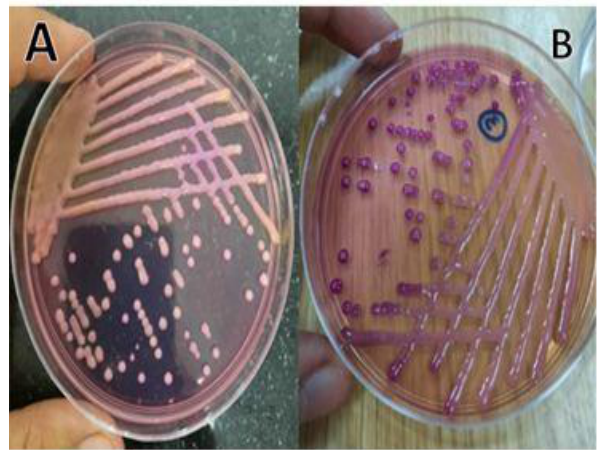
Fig.1: A: LAM of non- Acinetobacter growth, B: LAM of